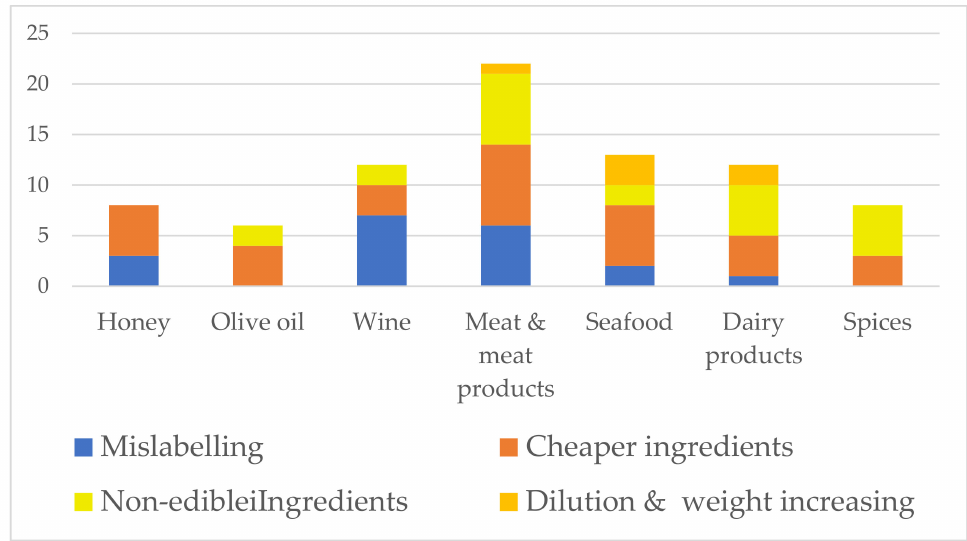
Figure 3. Types of unauthorized food manipulation (UFM) that occur most often in particular food groups